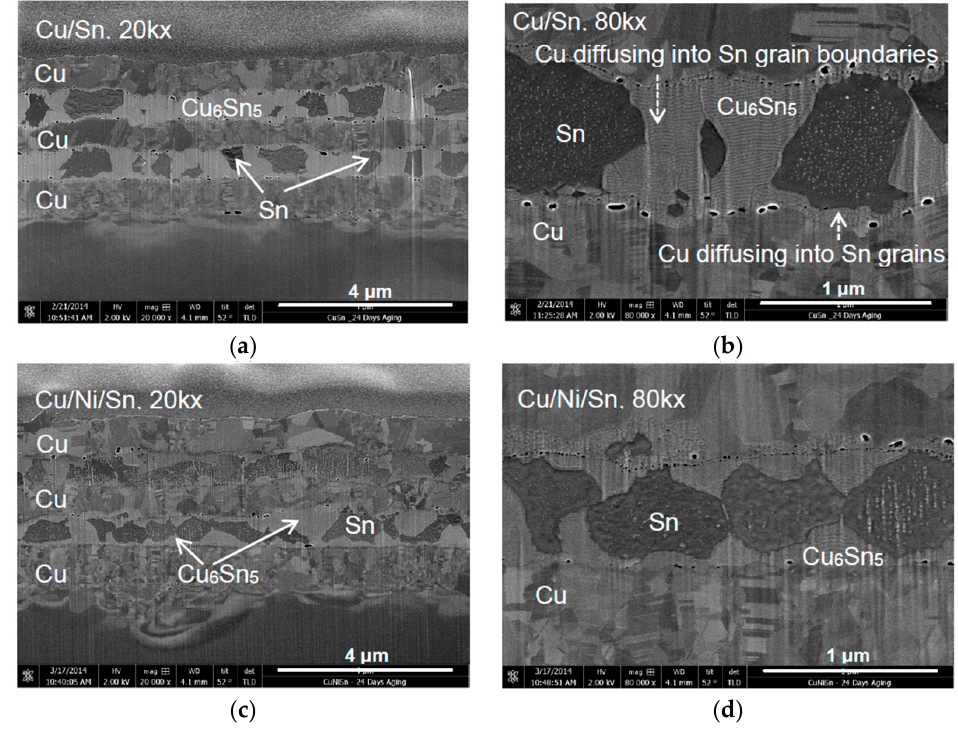
Figure 2. FESEM micrographs showing FIB milled cross sectional images of Cu/Sn ( a , b ) and Cu/Ni/Sn ( c , d ) aged at room temperature for 24 days at 20,000× and 80,000× magnifications, respectively.